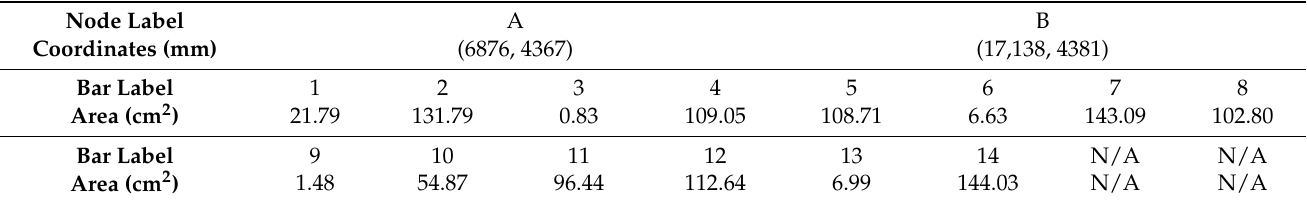
Table 11. Detailed data of the generated truss under multiple load cases I and II.